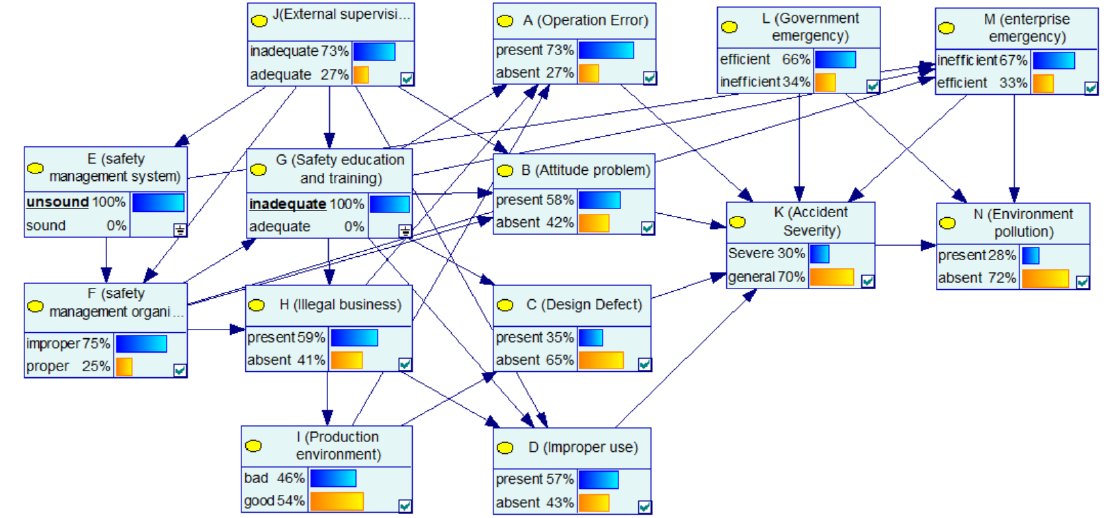
Figure 7. Case study for improper “safety management system” and inadequate “safety education and training“.